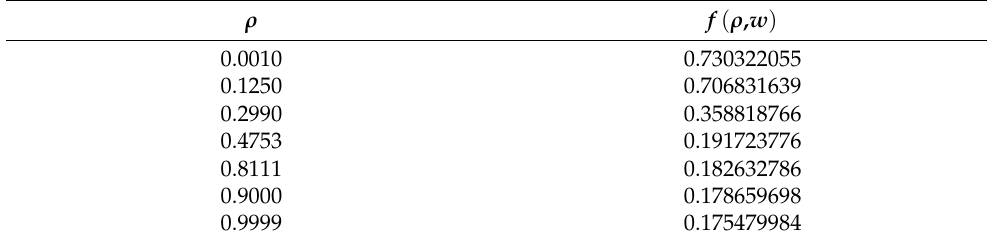
Table 1. Results for the first scenario of rho in D.S. type one.